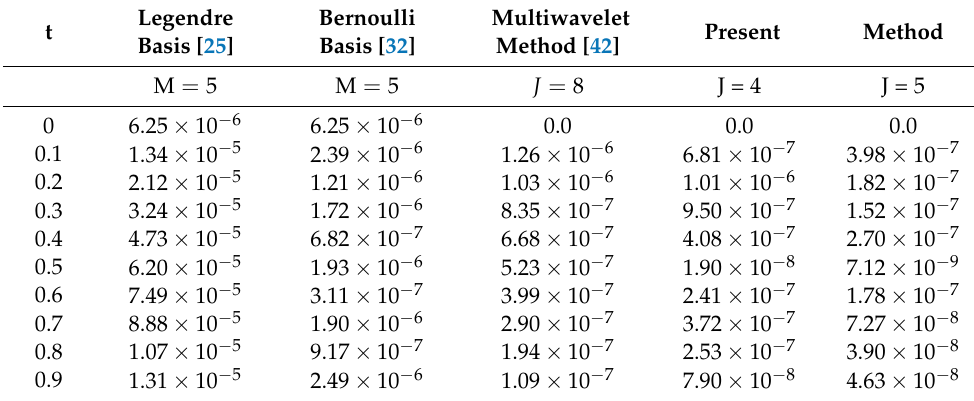
Table 1. Absolute errors of x ( t ) in comparison to the results from [25,32,42].